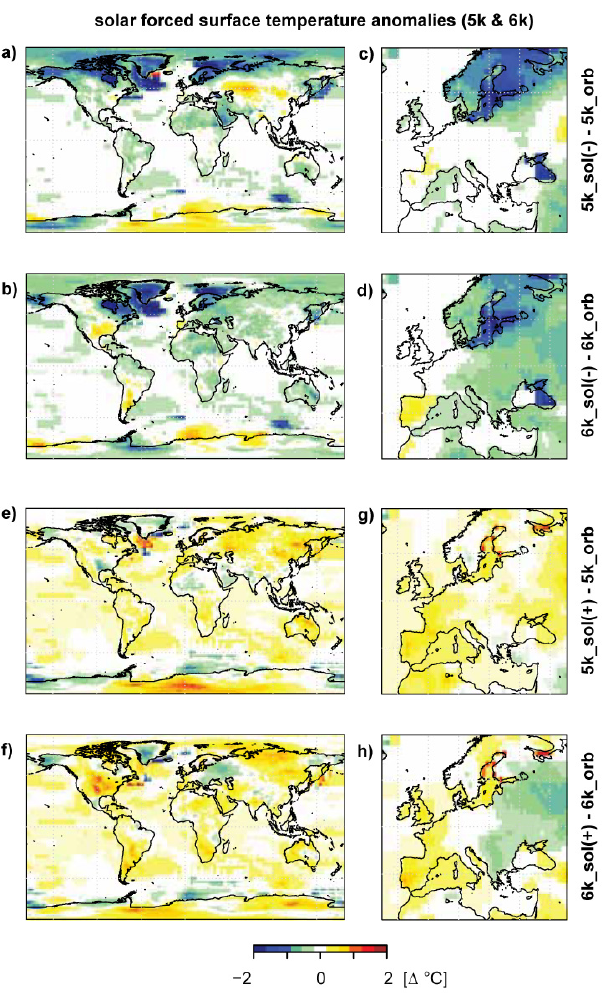
Fig. 7. Same as Fig. 6 but for δ 18 O in precipitation